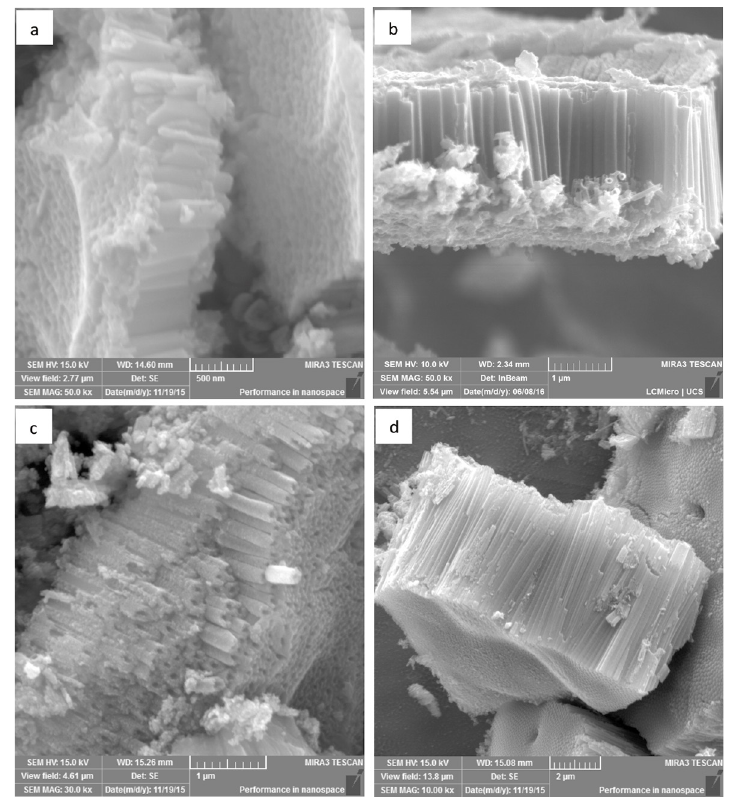
nanotubues obtained at (a) 60 2